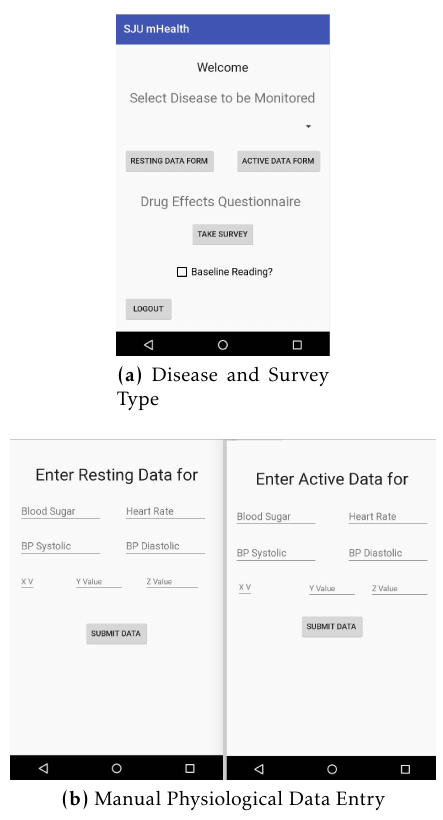
Figure 2. Screens for Disease and Physiological Data Entry Physiological and EMA data. Though the mobile application has no physical integration with